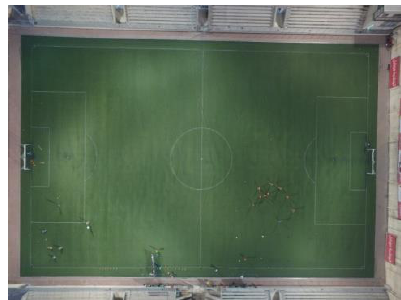
Figure 1. Municipal football stadium used for deriving the practical law